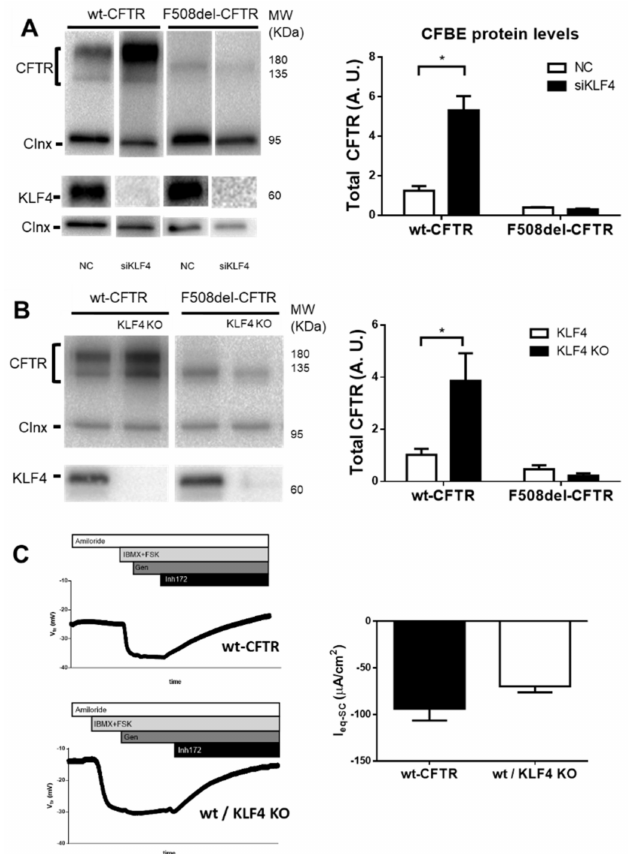
Figure 2. KLF4 knock-down / -out upregulates wt- but not F508del–CFTR. ( A ) Representative WB of KLF4 and CFTR expression in CFBE cells expressing wt- or F508del–CFTR and transfected with either siKLF4 or negative control (NC). Calnexin was used as loading control. Data are normalized to loading control and showed as arbitrary units (A.U.) (n = 3, unpaired t -test, p < 0.05). ( B ) Representative WB of KLF4 and CFTR expression in wt- and F508del–CFTR CFBE cells and their respective KLF4 KO (KLF4 − / − ). Calnexin was used as loading control. Data are normalized to loading control and showed as arbitrary units (A. U.) (n = 4, unpaired t -test, p < 0.05). ( C ) Ussing chamber experiments comparing wt-CFTR cells and their KLF4 KO counterparts. Comparable resistances were observed (wt-CFTR cells = 1400 ohm.cm 2 and wt-CFTR KLF4 KO cells = 1280 ohm.cm 2 ) (n = 3, unpaired t -test, p <